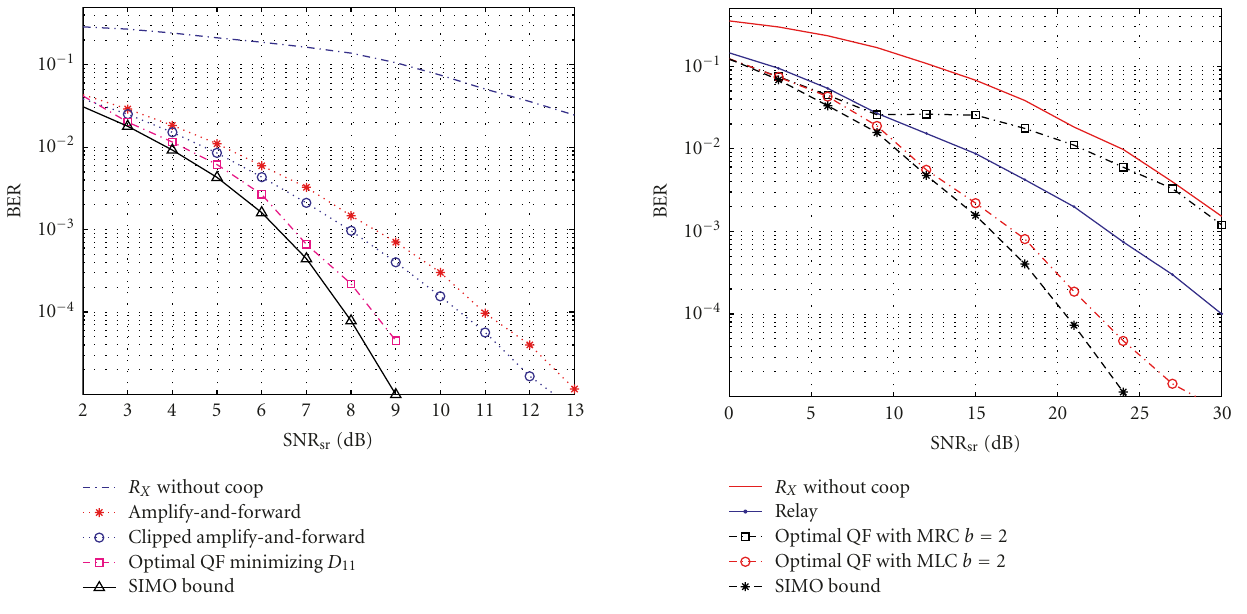
Figure 8: Influence of of the combining scheme for the opti- mal QF scheme ( b = 2) in quasistatic channels with { SNR rd = 10dB,SNR sr = SNR sd − 10dB }